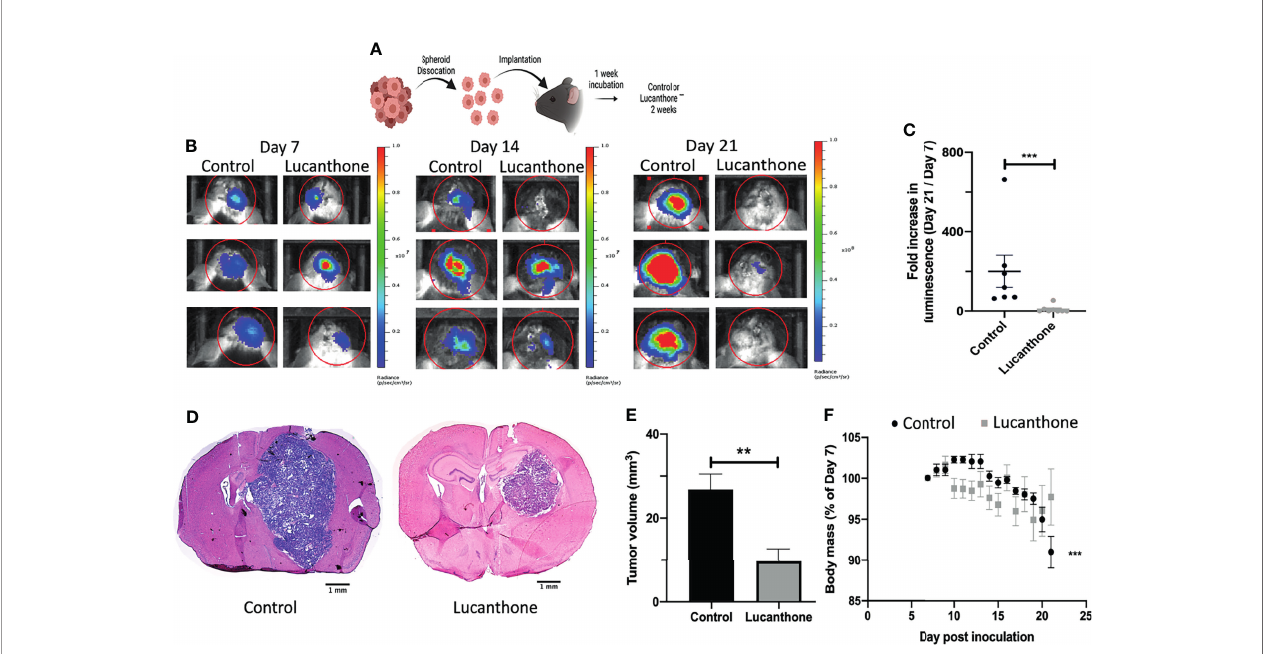
FIGURE 5 | Lucanthone mitigated the growth of dissociated GLUC2 spheroids in vivo . (A) Treatment scheme used for the study. (B) Representative images of in vivo luminescent imaging on Days 7, 14 and 21. (C) Fold increase in luminescence from day 7 to day 21. ***p < 0.001, Mann-Whitney test. (D) Tumor volume of control- and lucanthone-treated animals with representative images shown in (E) **p < 0.01, Mann-Whitney test. (F) Body mass depicted as a percentage of the start of treatment on day 7. ***p < 0.001, Mann-Whitney test, compared to relative body mass on day 7. Bars are mean +/- SEM, N=7-8